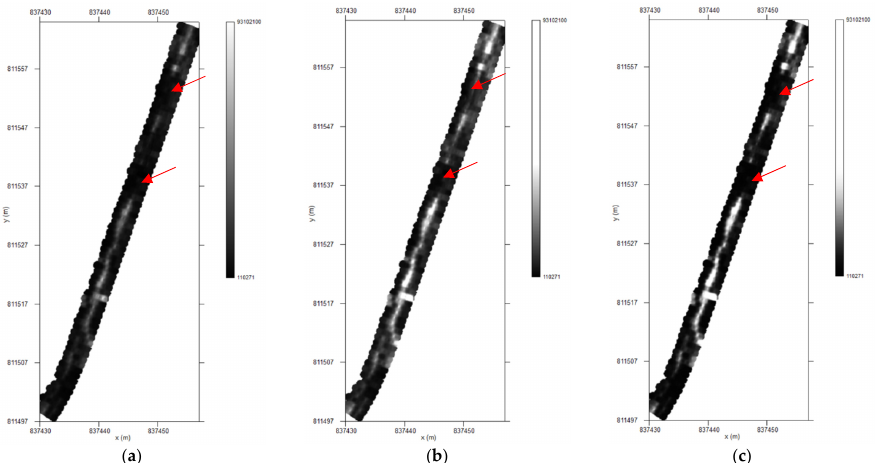
Figure 7. Visualised C-scans of different intensity normalisation methods: ( a ) linear transform all intensity values, ( b ) linearly transform an intensity portion of NSD = 2, and ( c ) bipolar transform a intensity portion of NSD = 2. Markers with red arrows indicate leaking points on the concrete util- ity.